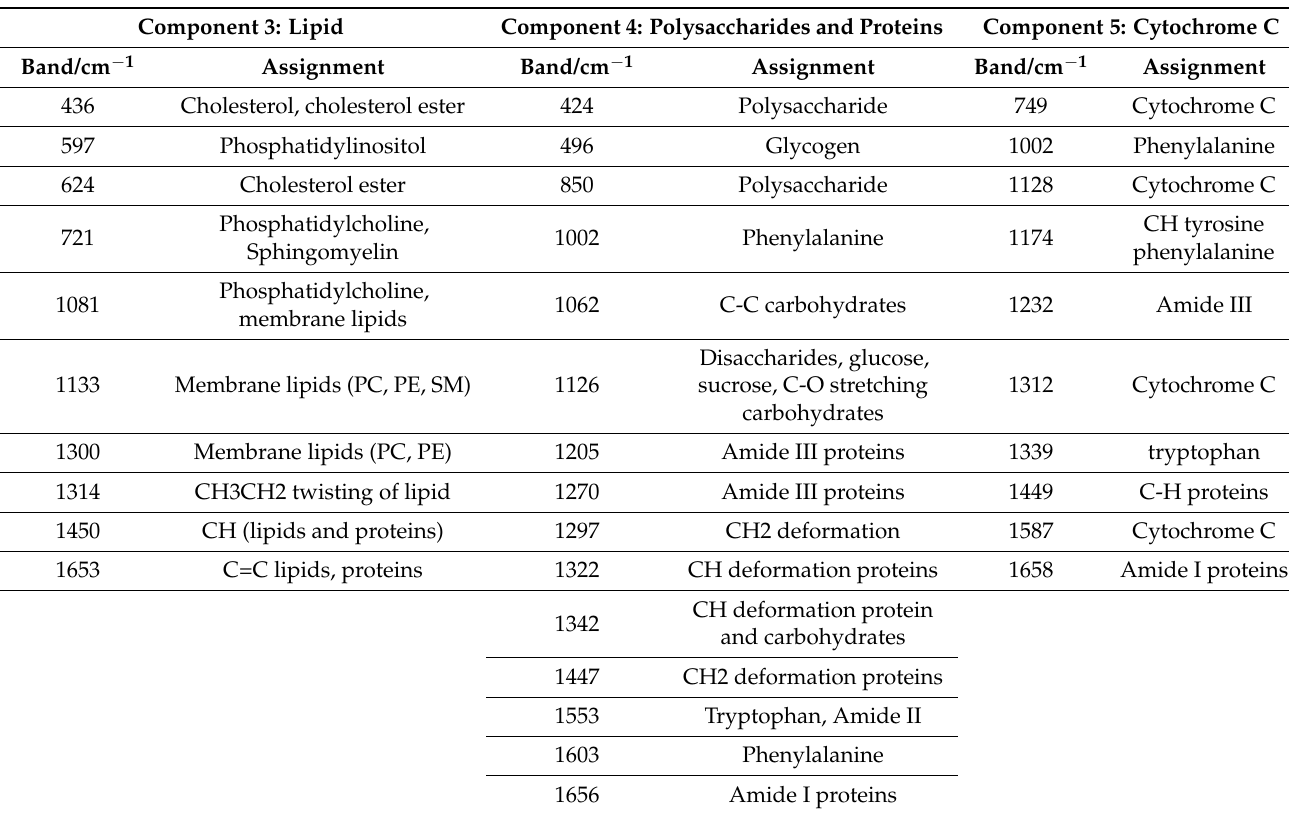
Table 3. Bands and assignments of molecular spectral components extracted from MCR analysis of the Raman image of the tissue HAp calcification shown in Figure 2. Assignments were based on the literature